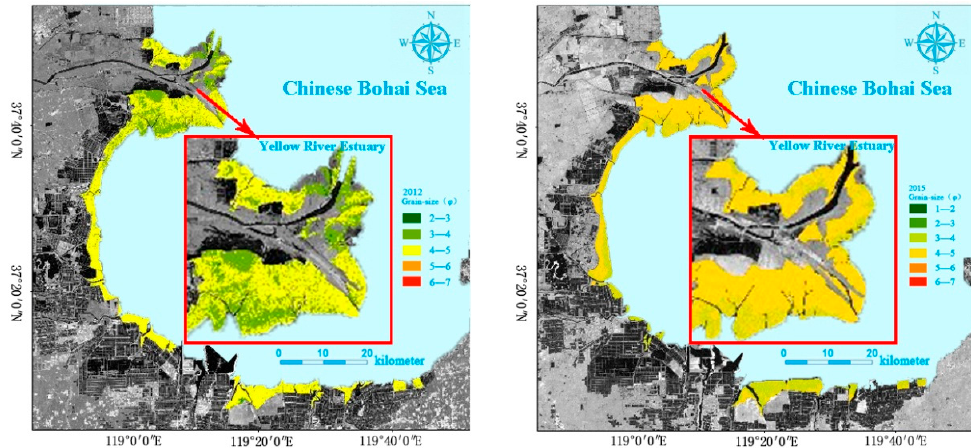
Figure 11. Spatial and temporal distribution of mean grain-size from 1989 to 2015.